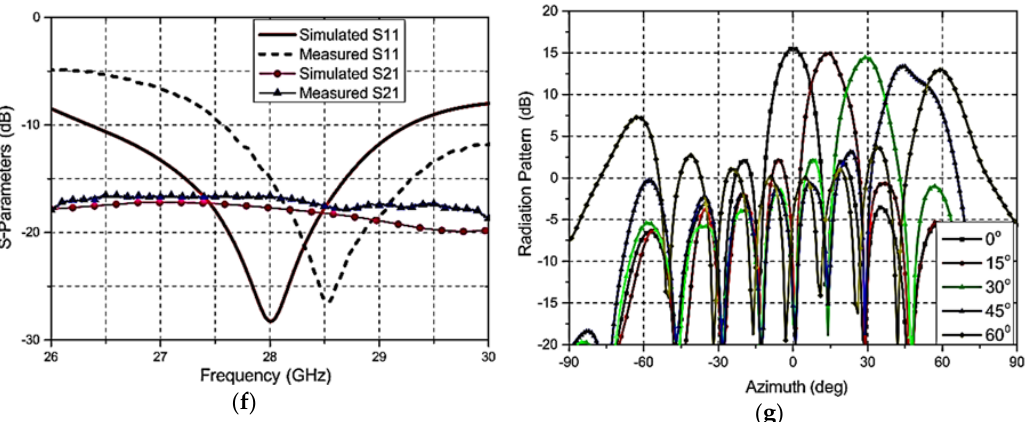
Figure 13. ( a ) Different views of mobile terminal design. ( b ) Photograph of mobile terminal with proposed phased ‐ array antennas. ( c ) Design of proposed eight ‐ element antenna array. ( d ) Block diagram of eight ‐ element beam ‐ steering antenna array. ( e ) Block diagram description of 28 ‐ GHz front ‐ end RFIC chip. ( f ) Simulated and measured input reflection coefficients and isolation between array elements. ( g ) 2D radiation plots at different scanning angles (Redrawn from [41]).